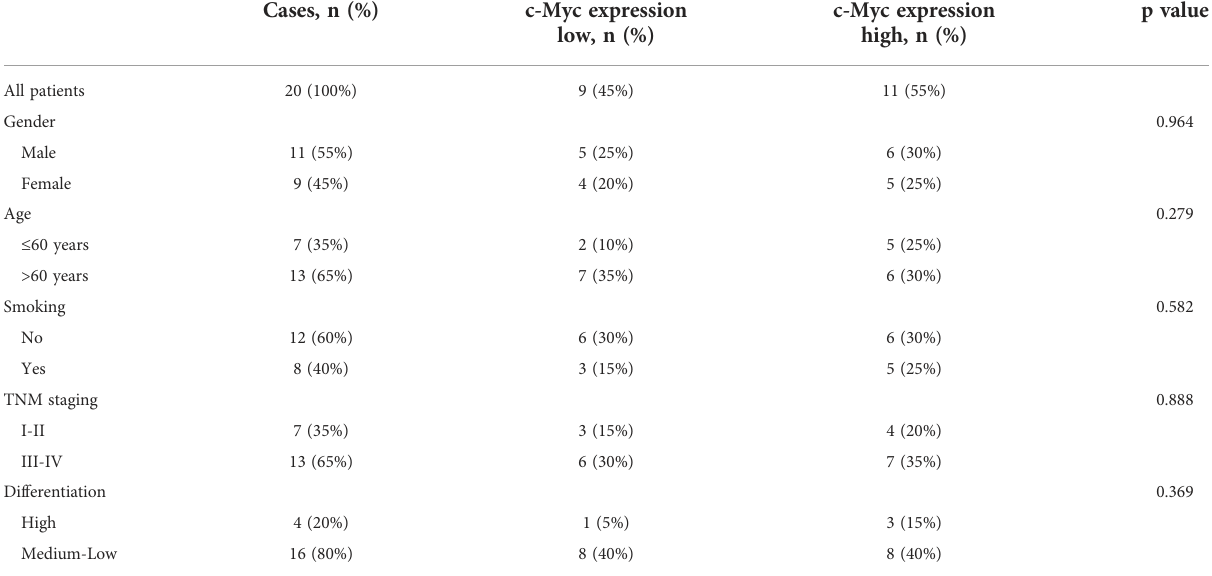
TABLE 1 The relationship between c-Myc expression and clinicopathological features of OSCC patients. Cases, n (%) c-Myc expression c-Myc expression